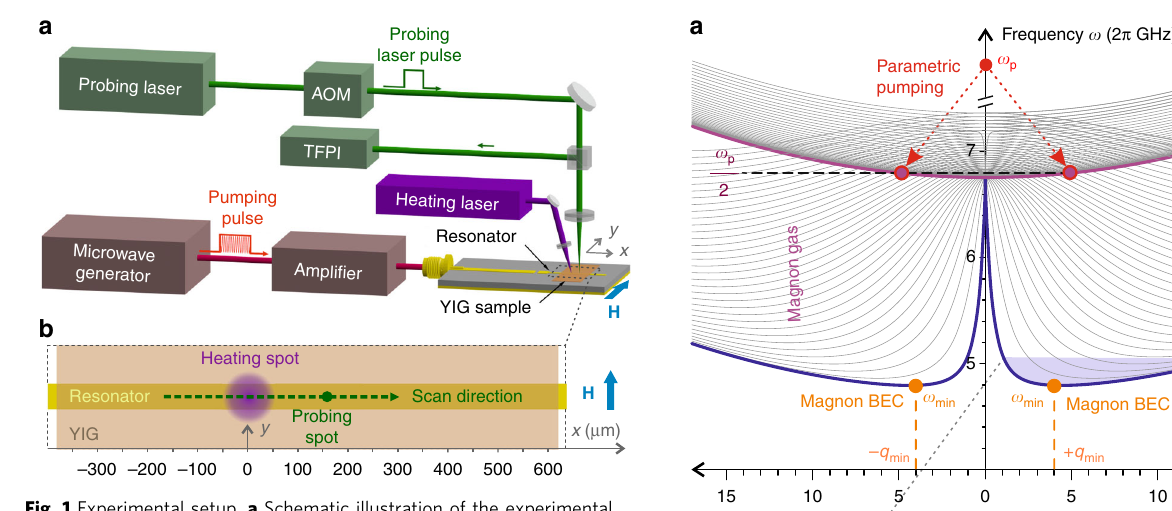
Fig. 1 Experimental setup. a Schematic illustration of the experimental setup. A probing green laser beam of 532 nm wavelength is focused onto a YIG- fi lm sample, which is fi xed on top of a pumping microstrip resonator